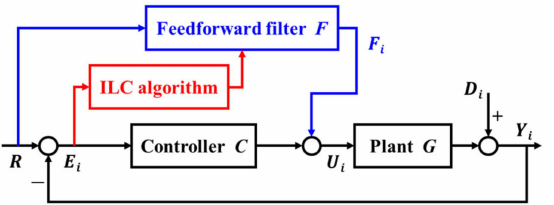
Figure 3. Suspension control block diagram of nonlinear IIC based on